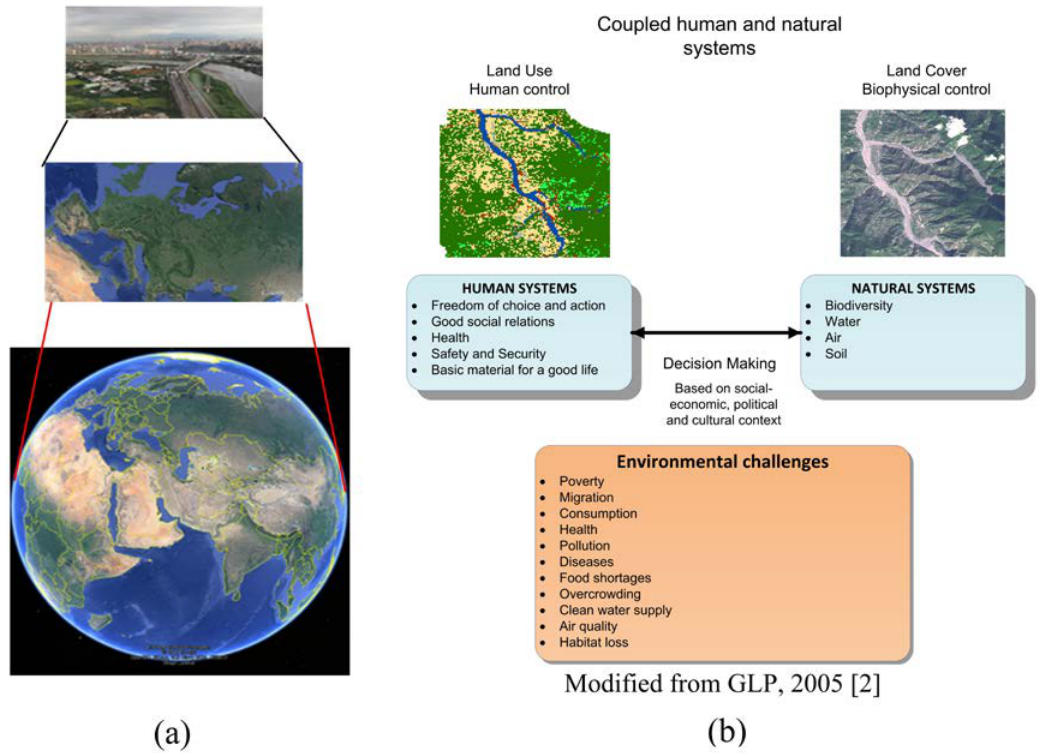
Figure 1. ( a ) Environments consist of human and natural systems across global and local scales (the first and second pictures from Google Earth); ( b ) Coupled systems (modified from Global Land Project (GLP), 2005 [2]).